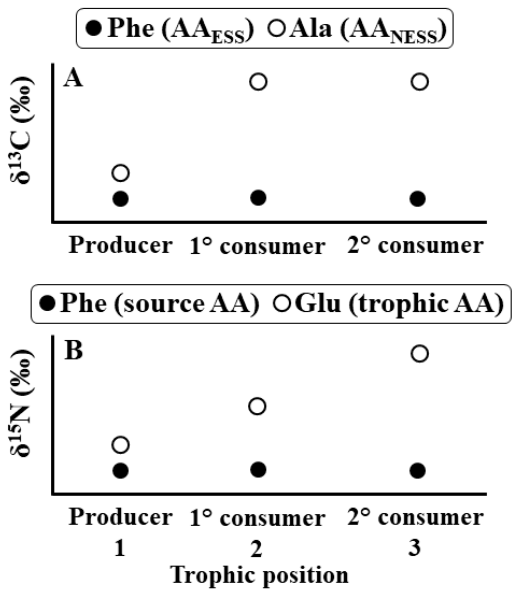
Figure 1. Idealized isotope values are shown for two amino acids (AA) in tissue from three different organisms, including a primary producer, a primary consumer (1 ° ), and a secondary consumer (2 °